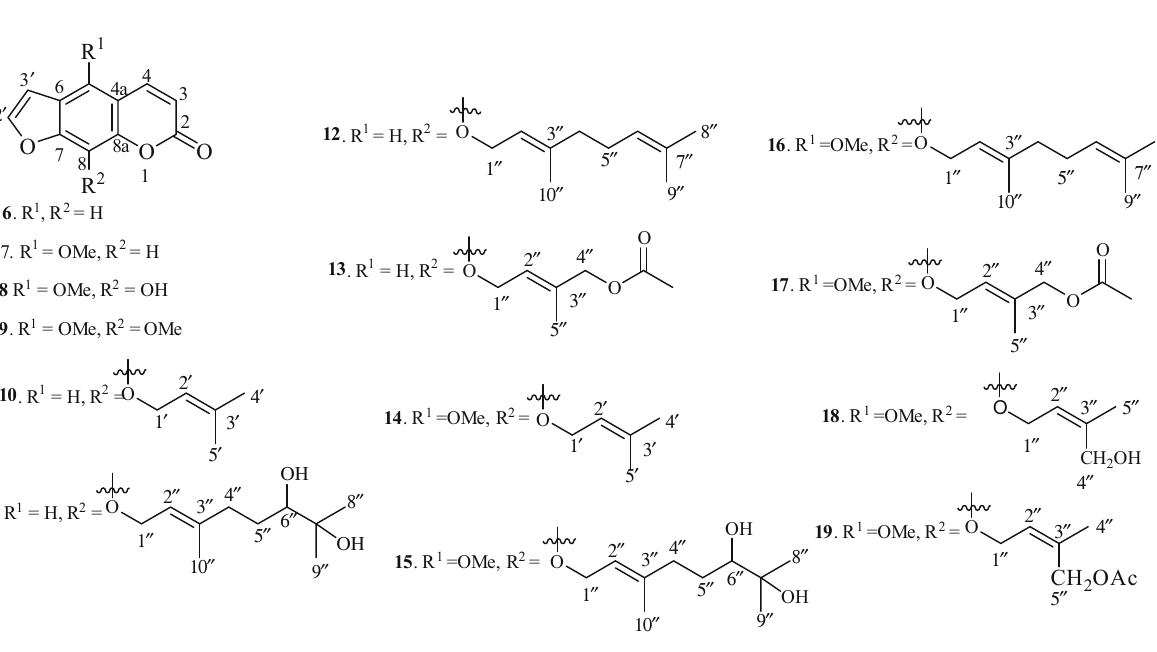
Figure 2: Structures of furanocoumarins from Casimiroa .